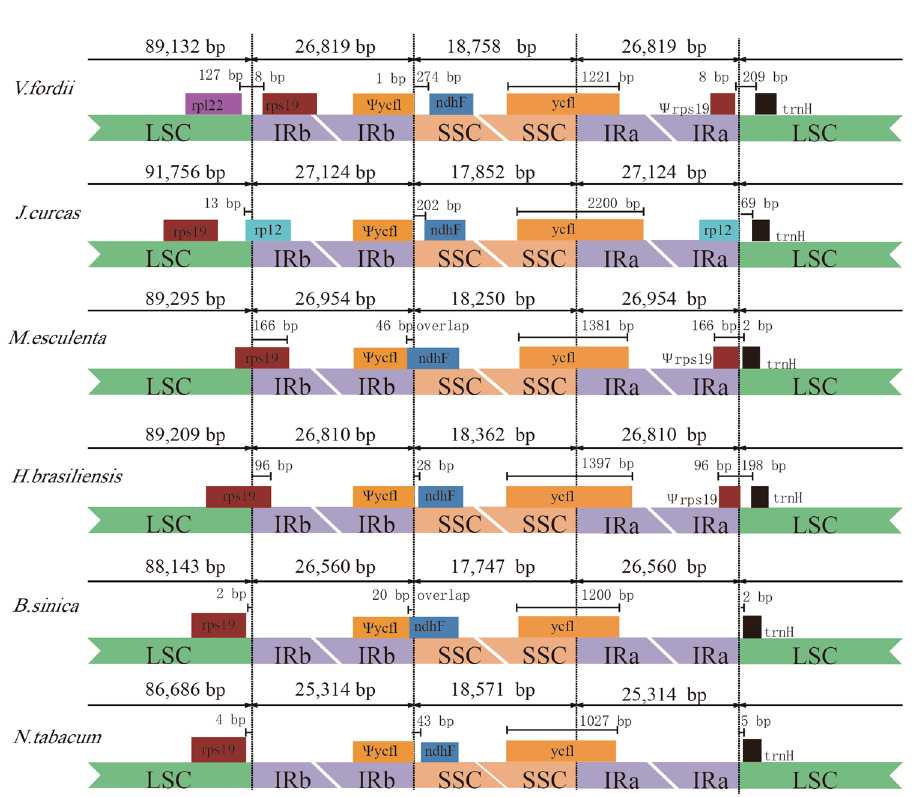
Figure 3. Comparison of the border regions of LSC, IR and SSC among six chloroplast genomes of basal